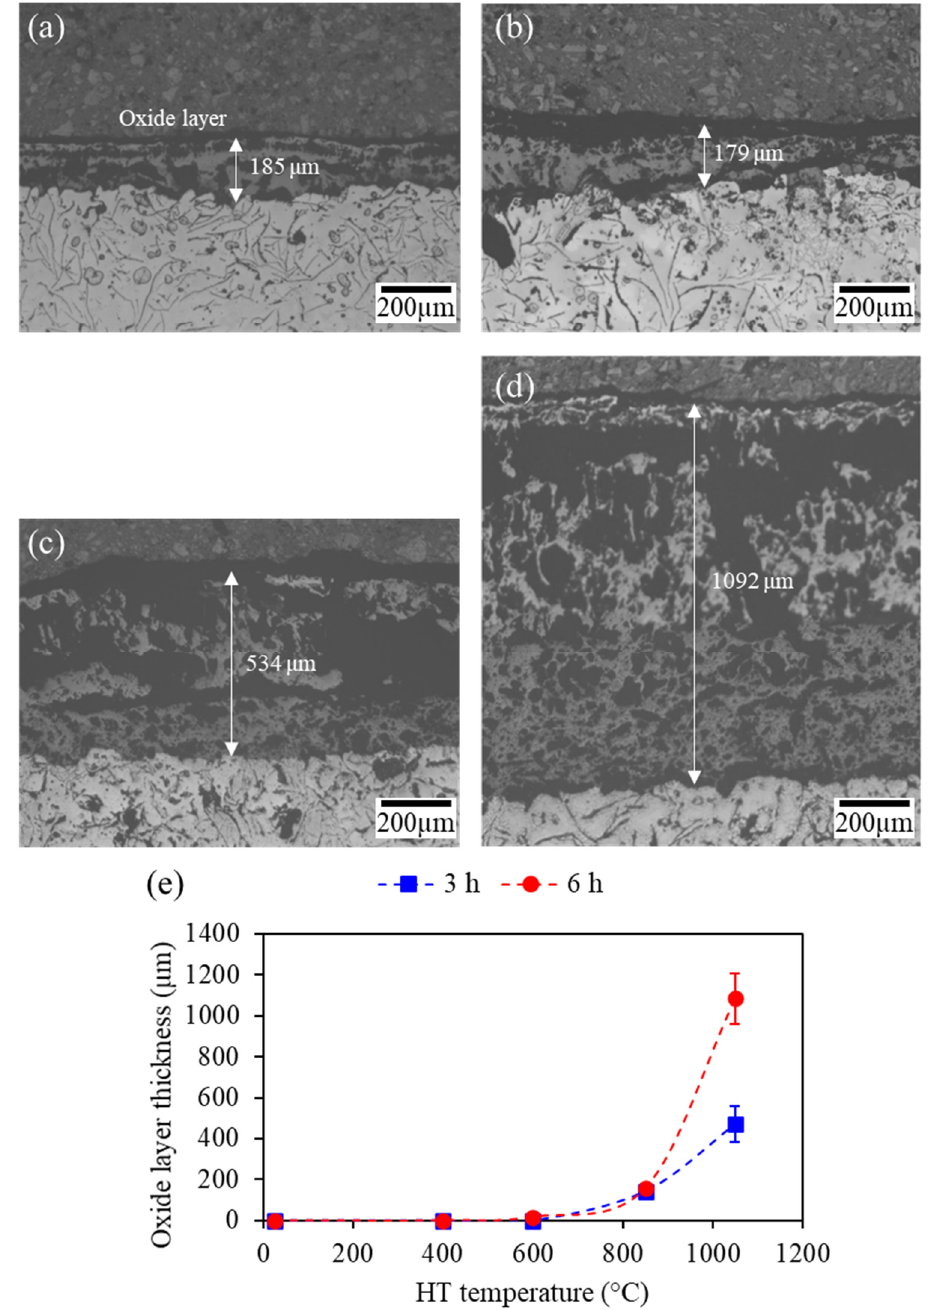
Figure 8. Oxide growth at the uncoated substrate area for ( a ) 850-3, ( b ) 850-6, ( c ) 1050-3, and ( d ) 1050-6 samples; and ( e ) Oxide layer growth as a function of heat treatment temperature and duration of the grey cast iron (GJL250) substrate.